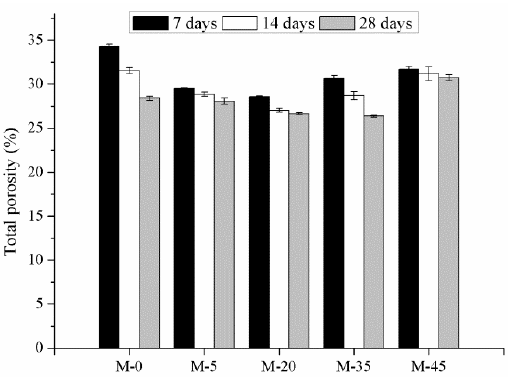
Figure 3. Total porosity values obtained for the studied mortar specimens (Error bars represent standard deviation).